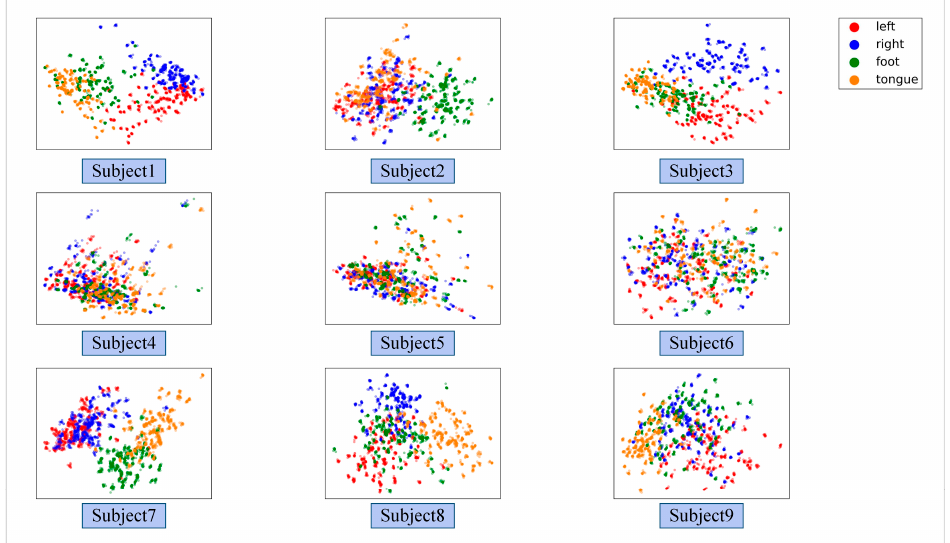
Figure 13. The scatter plot of feature distribution of 9 subjects under the CSP-LDA model. Table 3. Comparison table of the proposed method with other